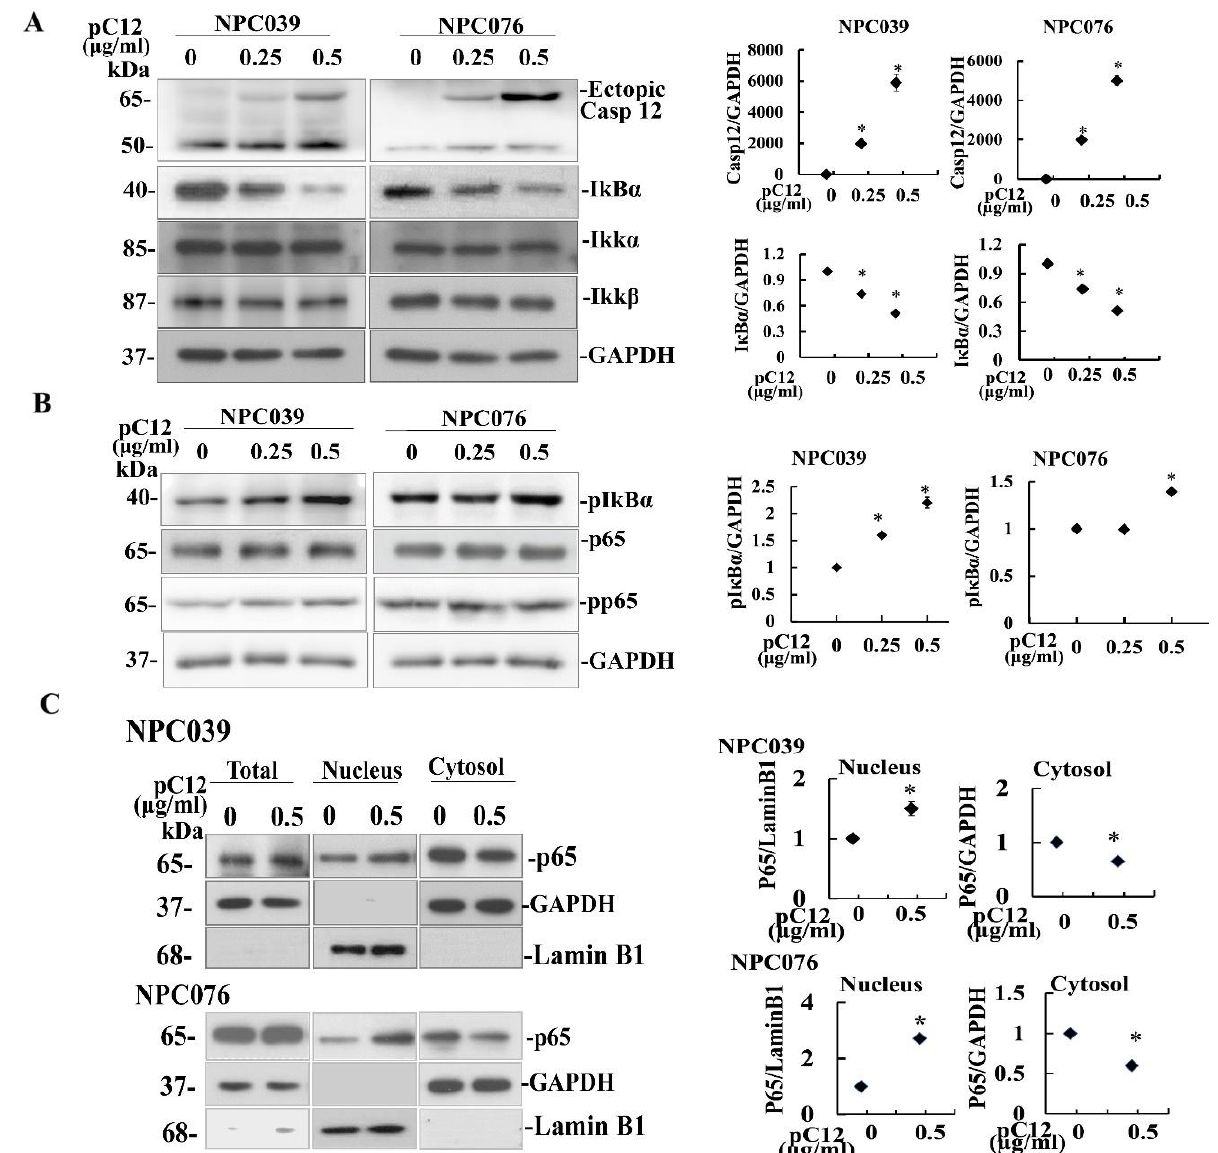
Figure 1. Casp12 decreased the IκBα protein and the p65 nuclear translocation. NPC cells were transfected with pC12 (0 – 0 .5 μg /mL) for 24 h. ( A , B ) Ectopic hCasp12 decreased the expression level of IκBα protein , but increased the phosphorylated level of IκBα . The total cell lysates were subjected to western blot, and underwent immunoblotting for the indicated antibodies (Casp12, IκBα, IKKα , IKK β, pIκBα, pp65, p65 , and GAPDH). Endogenous Casp12 (45 kDa) and GFP-hCasp12 (~65 kDa) were detected with the anti-Casp12 antibody. The blot shown is one representative of three independent experiments and one replicate per treatment. Densitometric analysis of the detected protein immunoblot results normalized to GAPDH. Values are relative to un-transfected (Cnt) and are plotted as arbitrary units. ( C ) Ectopic expression of Casp12 induced the p65 nuclear translocation. NPC cells were transfected with hpC12 (0 – 0.5 μg /mL) for 24 h and then the cytoplasmic fraction and nuclear fraction underwent western blot analysis with indicated antibodies. GAPDH was shown as the cytoplasmic loading control. Lamin1 was shown as the nuclear loading control. The data from three independent experiments ( n = 3) are graphed as the mean ± s.e.m. Data from each experimental group were compared with the control group by analysis of variance. * p < 0.05.